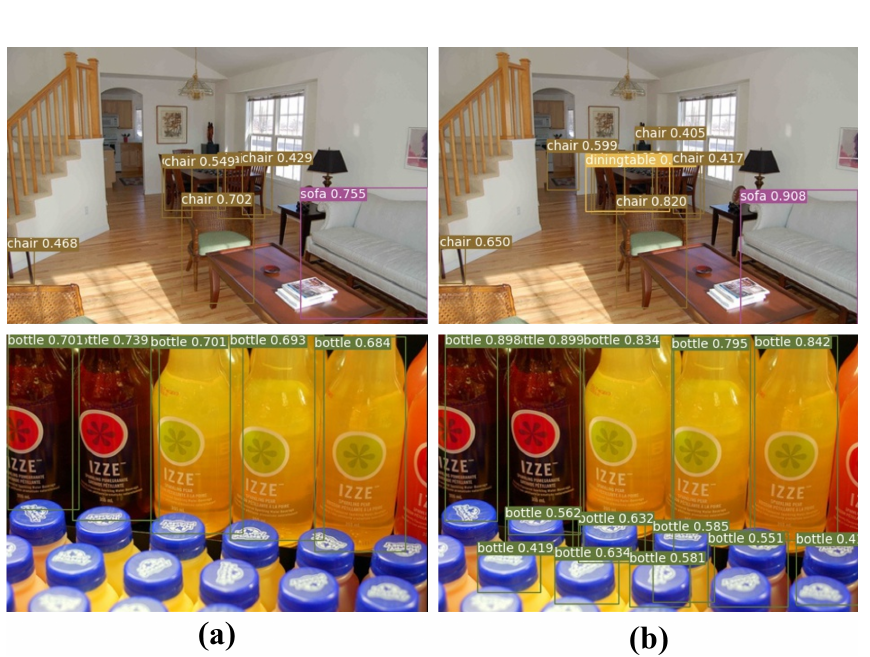
Figure 7. Comparison of detection results of the PASCAL VOC 2007 test dataset. ( a ) FCOS and ( b ) proposed HISFCOS method can effectively detect overlapping